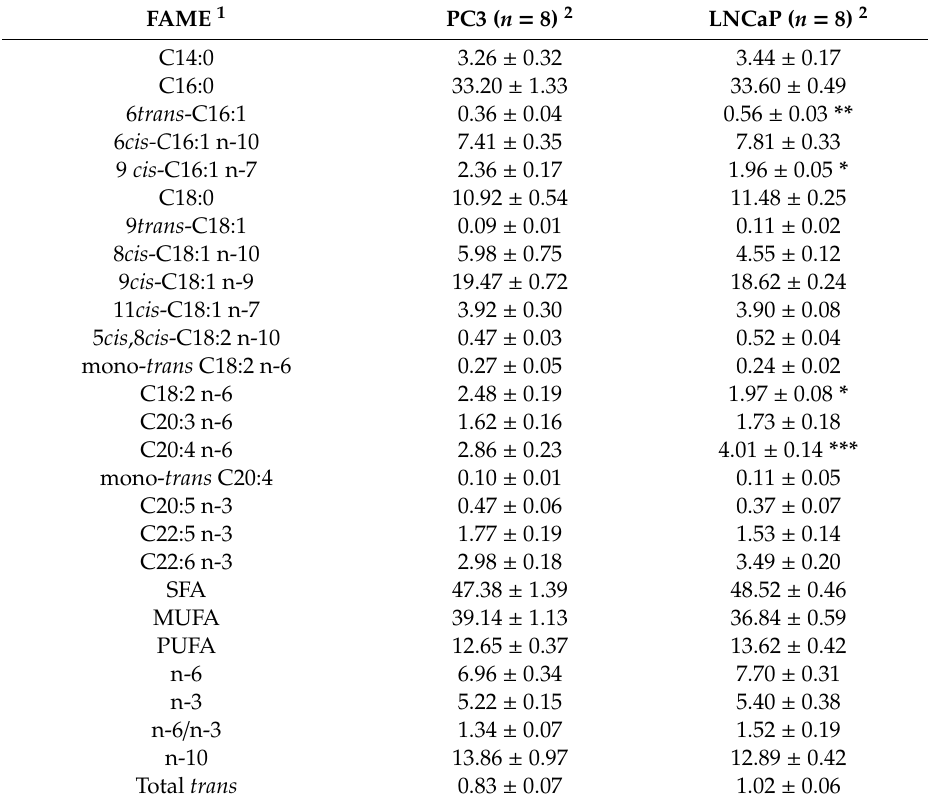
Table 1. Fatty acid methyl esters (FAME) (% relative quantities, %rel. quant.) obtained from membrane phospholipids of two di ff erent prostate cancer cell